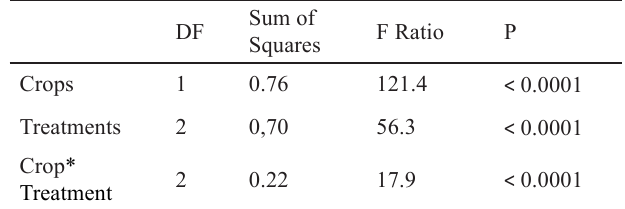
Fig 1 . Average density of weaver ant tree-1(± SE) (A) and average number of weaver ants nests tree-1 (± SE) (B) on cashew and mango crops. N= 72 trees per treatment in each crop. Table 1 . Two way ANOVA test for comparison of weaver ant mean density index per tree between crops (mango and cashew) and treat- ments (ants, ants feeding and ants + GF-120). N = 432